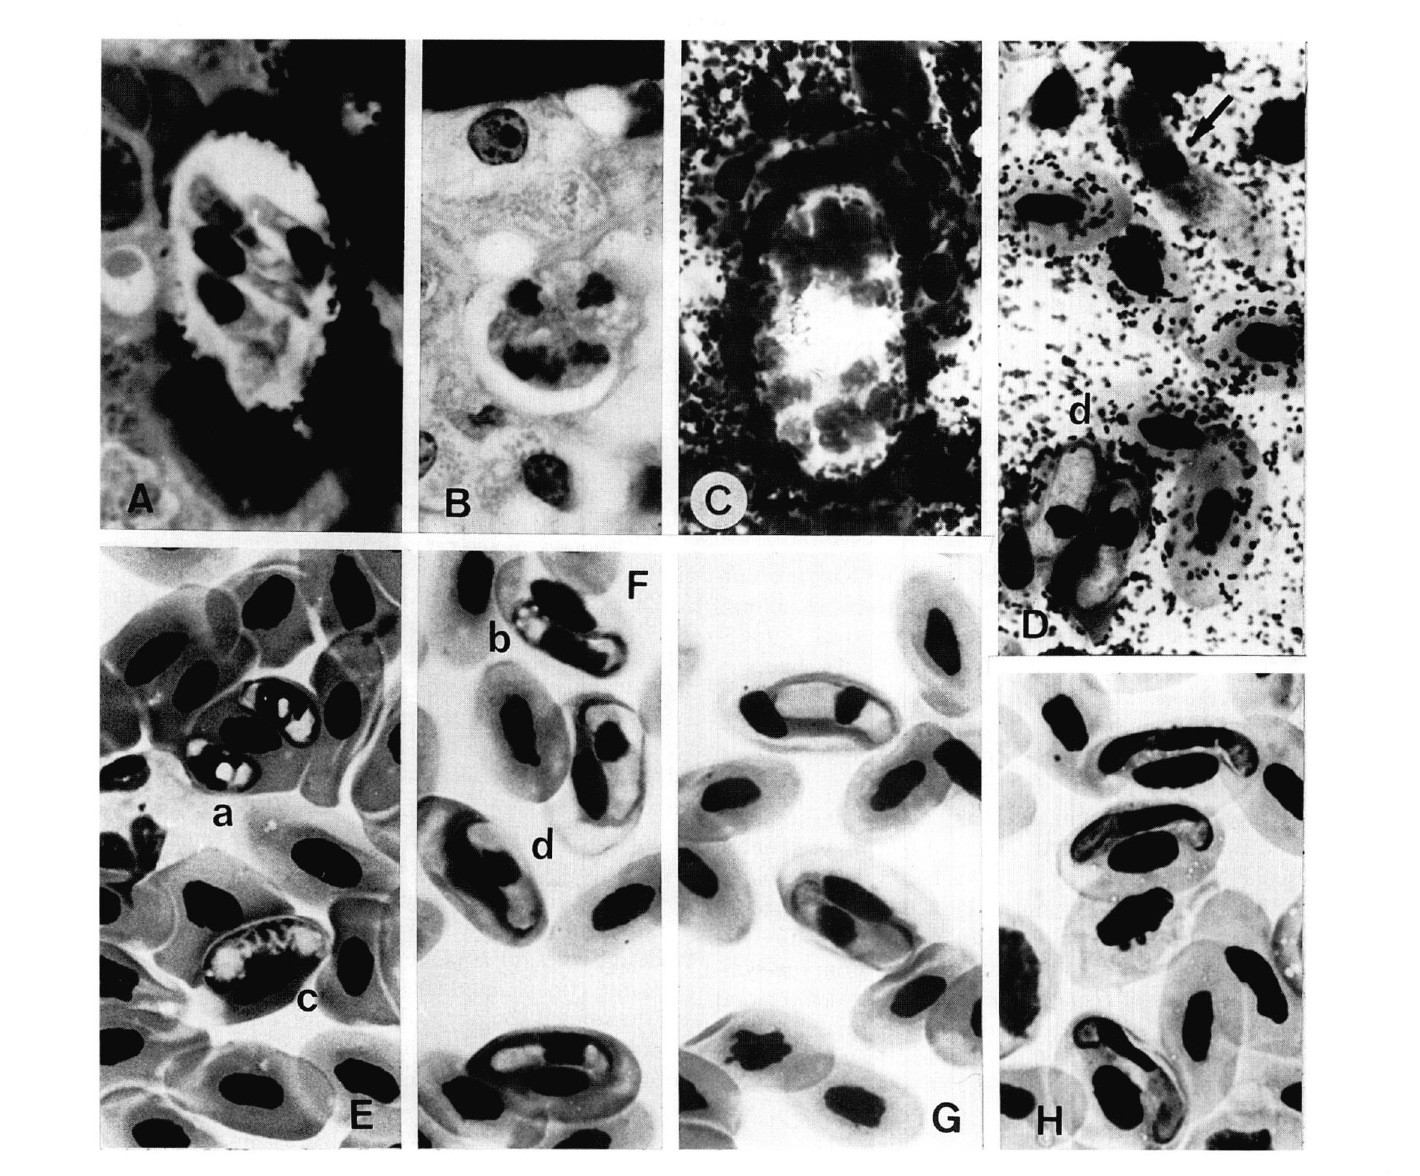
Fig. 2. - Stages of Hepatozoon kisrae n. sp. from Agama stellio (x 1,300). A-D, from the liver: A. Four-zoite cyst-like meront; B. Meront dividing by polyendodyogeny; C. Polyzoic meront (macromeront); D. Undivided meront (arrow) and intraerythrocytic gametocytes (d). E- G: Gametocytes in the blood. E. Oval young (a) and premature with spirale nucleus (c); F. Premature with dense nucleus (b) and mature, encapsulated (d); G. Mature encapsulated; H. Hepatozoon sp. A. in blood of A. stellio from site e.